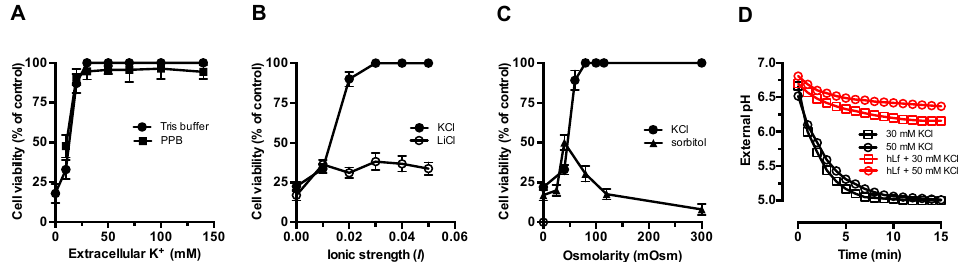
Figure 1. Influence of extracellular factors on lactoferrin-induced regulated cell death. C. albicans cells (10 5 cells/mL) were incubated with 5 μ M lactoferrin (hLf) for 90 min at 37 °C in the presence of ( A ) different extracellular K + concentrations in Tris buffer (circles) or potassium phosphate buffer (PPB, squares); ( B ) different ionic strength calculated in the presence of KCl (solid circles) and LiCl (open circles) solutions; or ( C ) equivalent osmolarity values of KCl (circles) or sorbitol (triangles) solutions. The cell viability was determined by a plate-count method. ( D ) E ff ect of extracellular K + on the interaction of lactoferrin with the H + -ATPase. The H + -extrusion mediated by the plasma membrane Pma1p H + -ATPase of C. albicans cells suspended in 30 mM KCl (squares) or 50 mM KCl (circles) was determined in the presence (red lines) or in the absence (black lines, control) of lactoferrin by monitoring glucose-induced acidification of the external medium. The results are the means ± SD from duplicates of at least three independent experiments. In Figure 1D, only the mean data ( n = 3) are shown, and the bars representing standard errors (coe ffi cient of variation of < 10%) are omitted for